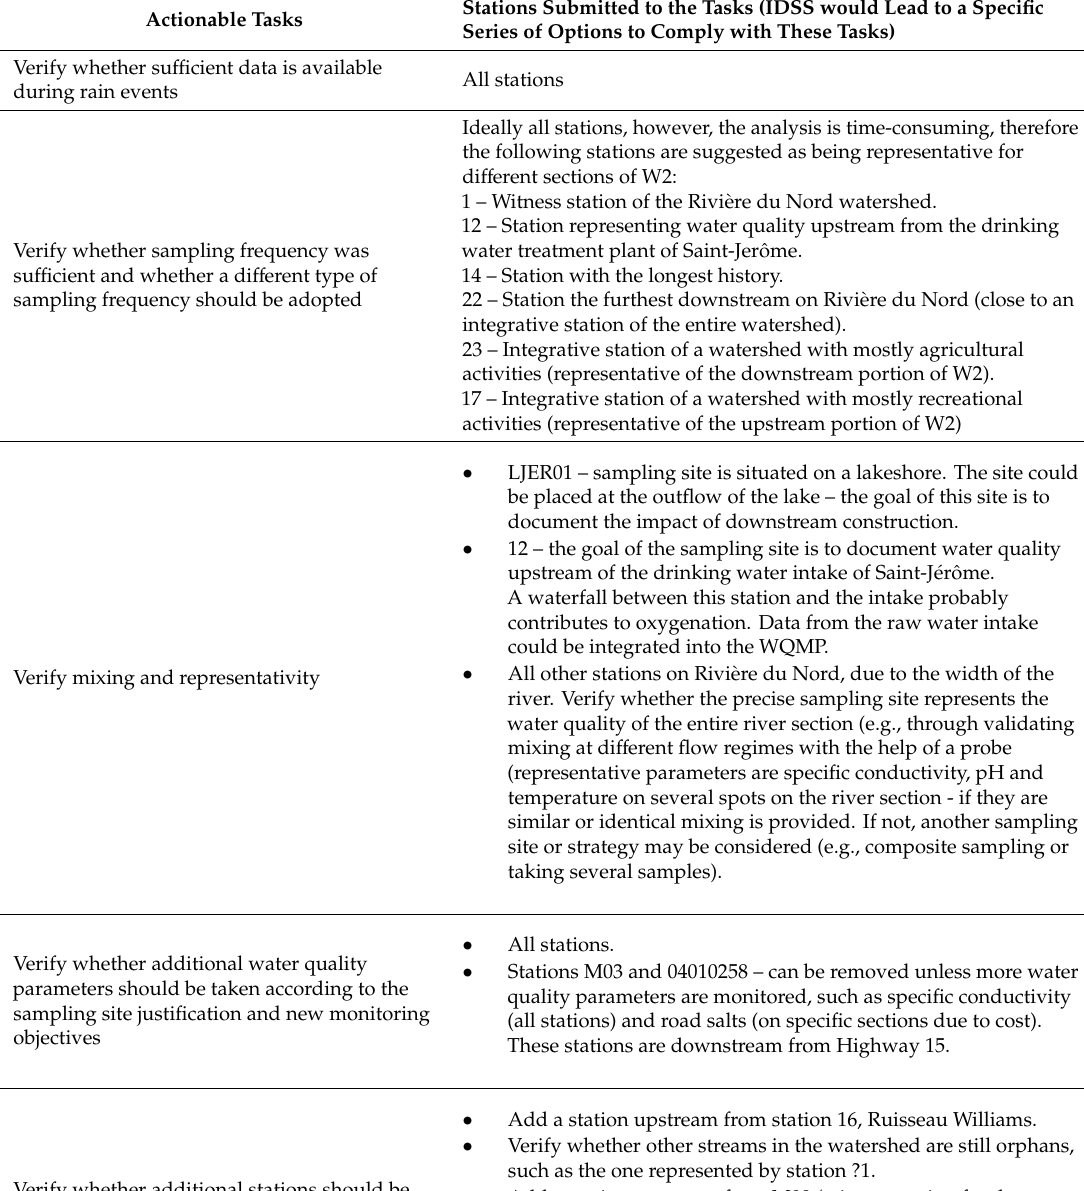
Table 2. Summary of the actionable tasks to take final decisions to optimize the W2 WQMP. Actionable